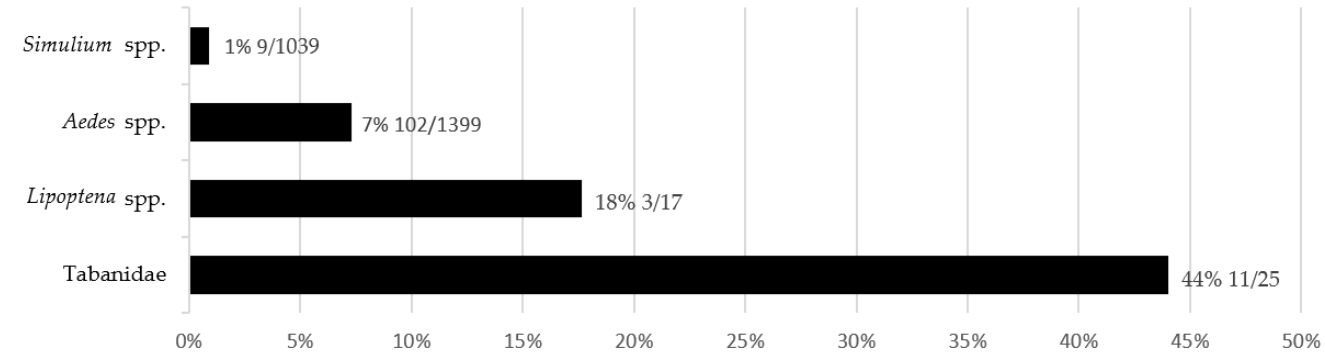
Figure 2. Comparison of T. theileri prevalence in bloodsucking insects. The prevalence of mosquitoes, tabanids, and blackflies is counted for insects trapped in the Milovice forest. The prevalence in deer keds was counted for insects collected at multiple localities.